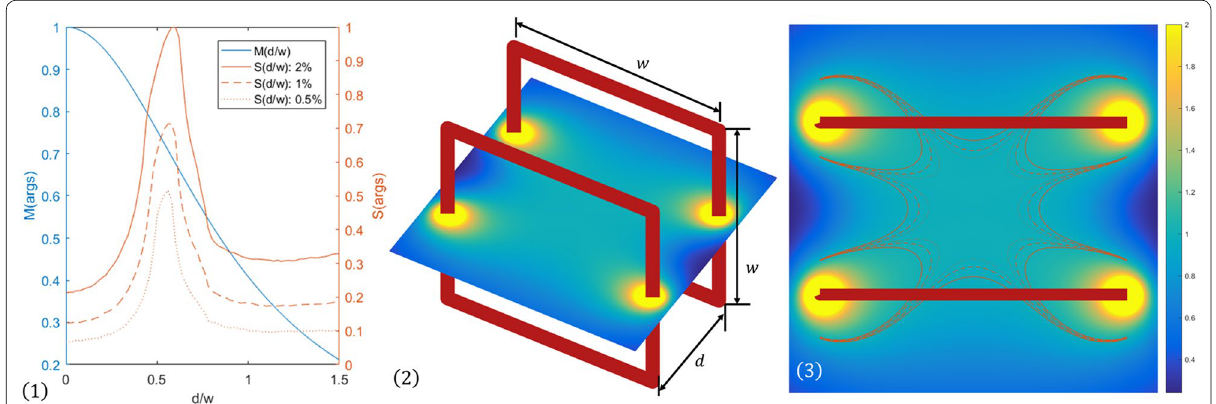
Figure 10 Optimization result for the squared-shaped coil pair inducing uniform magnetic